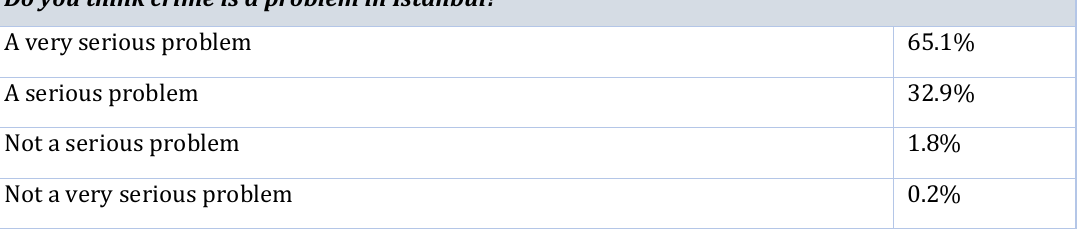
Table 1 : The seriousness of crime Do you think crime is a problem in Istanbul?